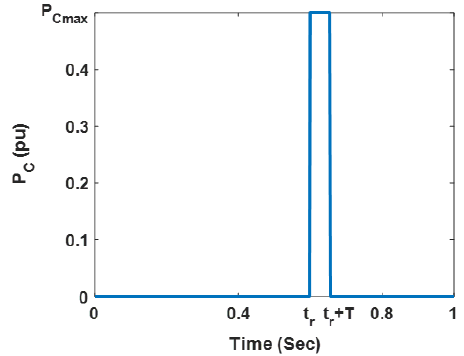
Figure 11. Input control power for the optimal control